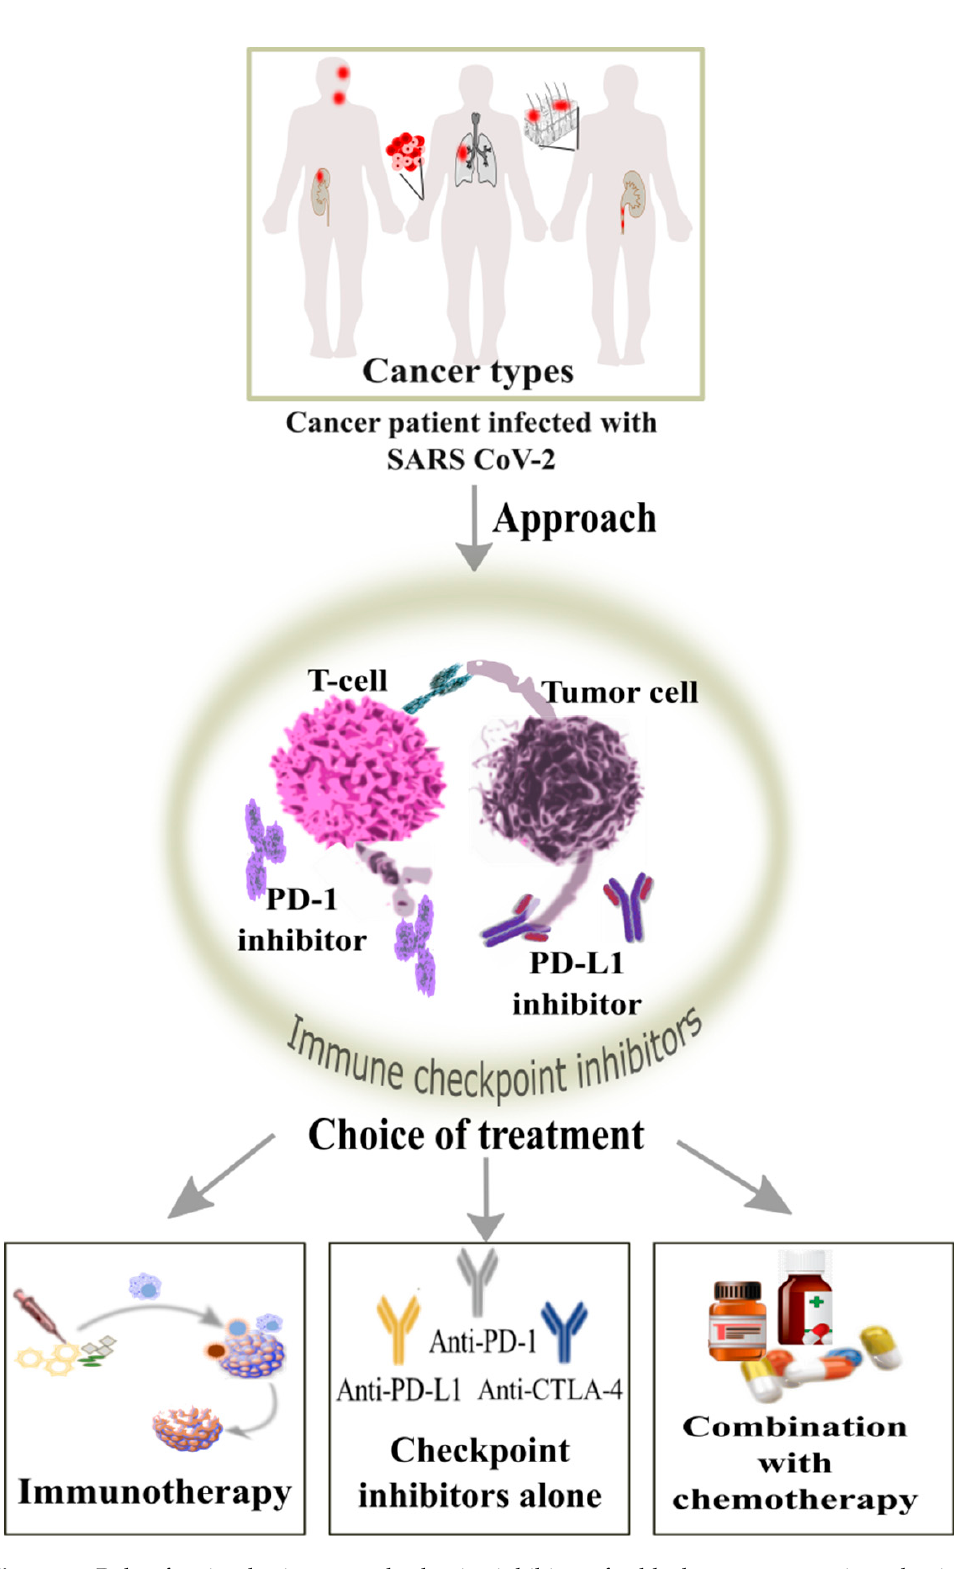
Figure 6. Role of action by immune checkpoint inhibitors for blockage cancer patients having solid tumors infected with SARS-CoV-2 can opt for the treatment by the use of immune checkpoint inhibitors such as anti-PD-1, anti-PD-L1 and anti-CTLA-4 antibodies which can increase the CD8+ T cell response and viral clearance. Table 1. Immune checkpoint inhibitors ongoing and completed clinical trials.